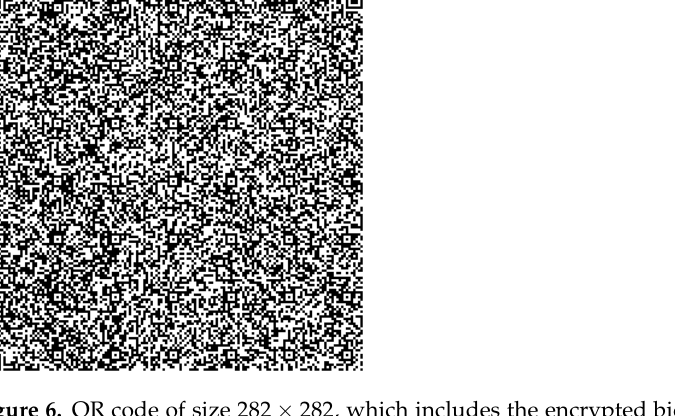
Figure 6. QR code of size 282 × 282, which includes the encrypted bio-signal feature vectors and confidential patient information.